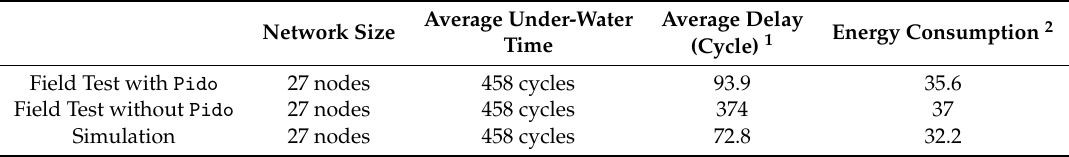
Table 4. The comparison of the field test results and simulation results.